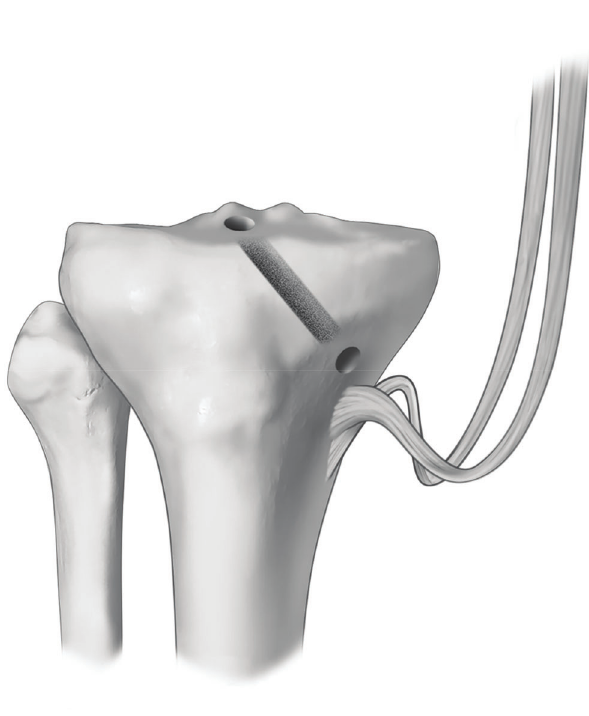
Figure 3 - Illustration of the dissected hamstring tendons and their maintained insertions. PLT: Posterolateral tunnel (relative to the posterolateral